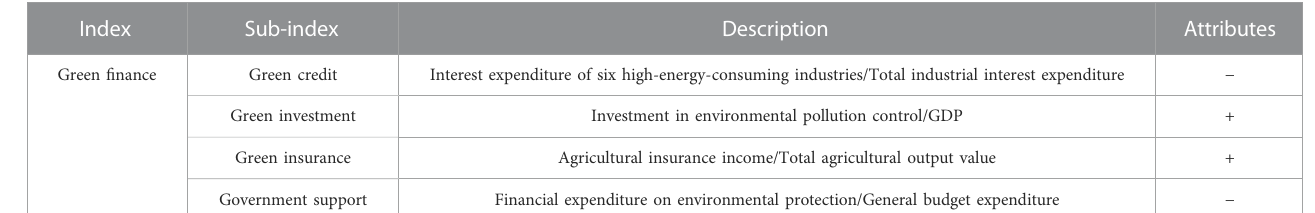
TABLE 3 System of green fi nancial indicator.